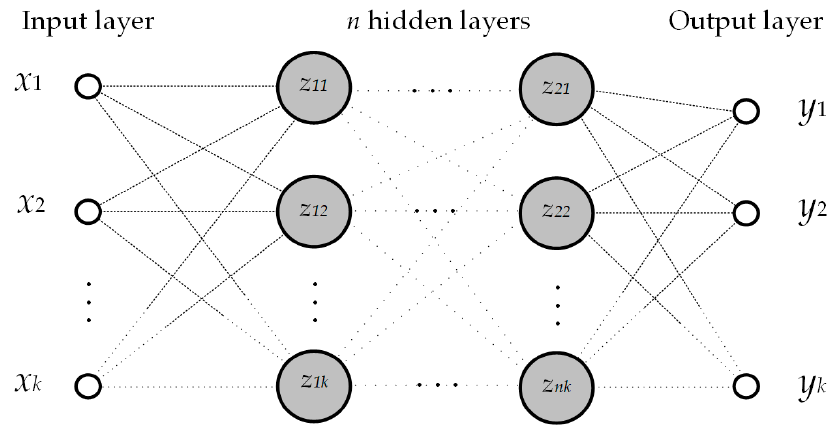
Figure 10. Multilayer perceptron neural network (MLPNN) architecture [20].